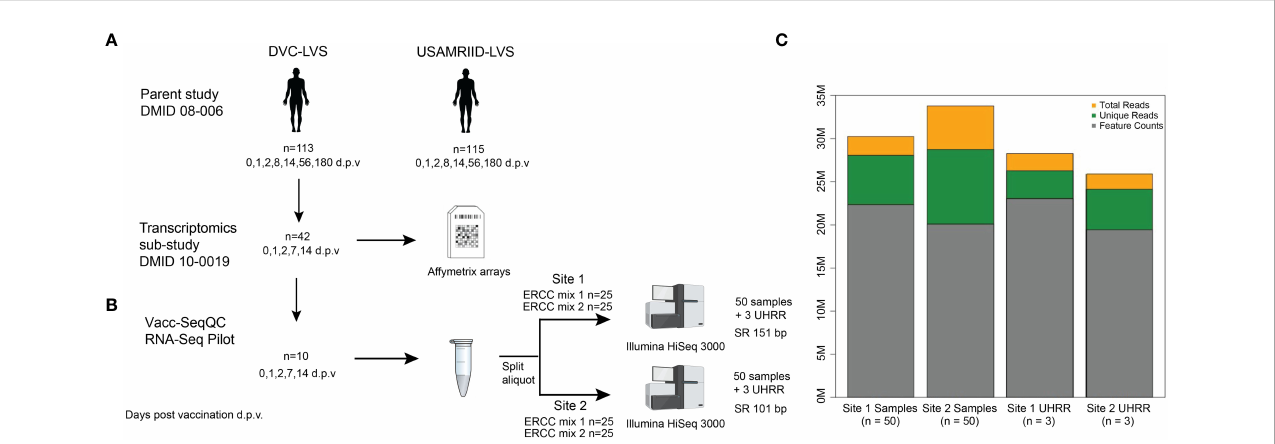
FIGURE 1 Experimental design of RNA-Seq benchmarking for the clinical vaccine study. (A) The samples utilized in this benchmarking experiment were obtained from parent study DMID 08-006 (ClinicalTrials.gov NCT01150695), of which 42 patients had RNA samples collected for microarray analysis. (B) RNA from fi ve time points taken from 10 volunteers, for a total of 50 samples, at both Site 1 and Site 2. Each biological sample was spiked with either ERCC mix 1 or mix 2, for 25 replicate spike-ins of each mix. Samples were sequenced as single-ended 151 or 100 bp reads on an Illumina HiSeq3000 at each Site, with multiplexing targeting a sequencing depth of 30 M reads. At each site, an additional set of three RNA samples from UHRR controls were included for an independent reference. (C) Median sequencing metrics for all samples at each site. The yellow bar indicates the median total sequencing depth obtained for all samples for each site; the top of the green bar indicates the total reads that are uniquely mapping to the GRCh38 reference, and the grey bar indicates the reads mapping to annotated features (i.e., genes) in the reference. Created with